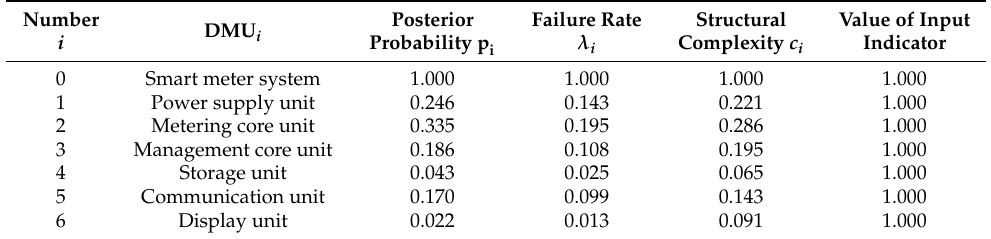
Table 6. Input and output matrix table.